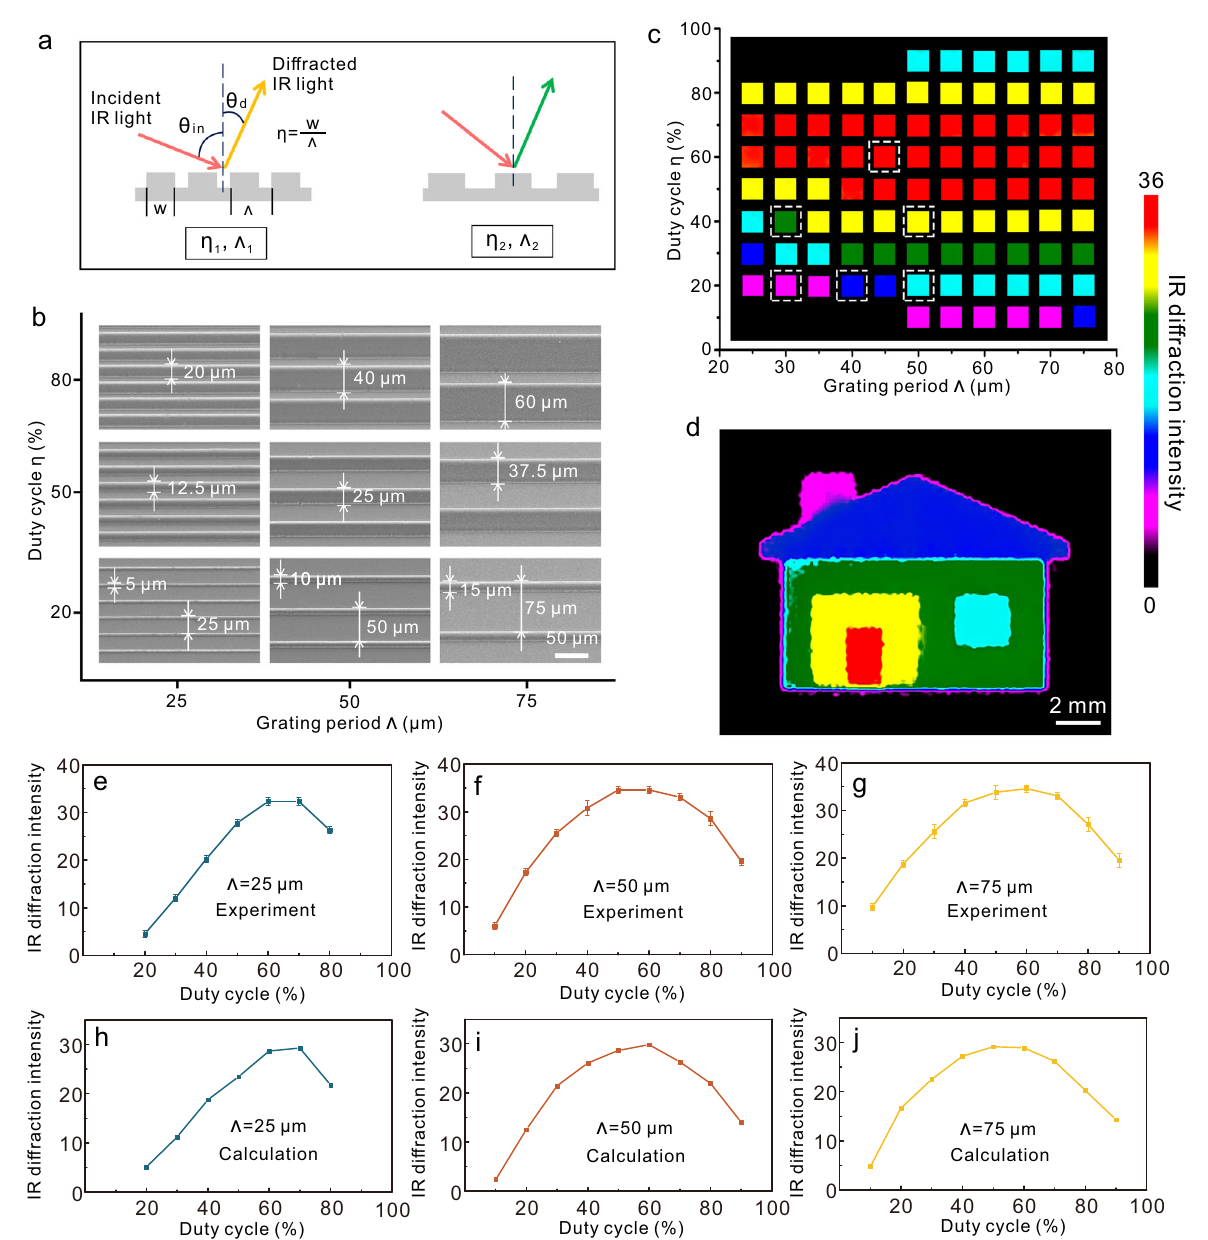
Fig. 2 The response of gratings with different structural parameters to human hand. a Schematic illustration of the interaction between light and gratings with different periods ( Λ ) and duty cycles ( η ). b SEM images of fabricated Al gratings. c The IR color palette generated based on different grating periods and duty cycles. d Color display of a “ house ” based on the selected gratings (dashed boxes) in Fig. 2c. e – g Experimentally measured IR diffraction intensity with different duty cycles. Error bars represent the standard deviation of the mean. h – j FDTD calculated IR diffraction intensity with different duty cycles. incident angle range of Gr and excluded in the incident angle With the fl exibility of adjusting the position of the fi nger, the fi nger can selectively interact with multiple different gratings for range of Gy and Gg, the IR detector will capture the IR structural color from Gr but not from Gy and Gg. If the fi nger moves to R2, the generation of dynamic structural colors. The diffraction which is included in the incident angle range of Gy and excluded equation (Eq. 1) shows that the incident angle ranges are different in the incident angle range of Gr and Gg, the IR detector will for gratings with different periods. With the smaller grating capture the IR structural color from Gy but not from Gr and Gg. period, the incident angle for − 1st diffraction angle θ d = 10° (m = − 1) is larger for one speci fi c wavelength. As shown in Similarly, when the fi nger further moves up to R3, which is Fig. 3d, compared to the grating (Gy) in the middle, the incident included in the incident angle range of Gg and excluded in the angle range (the red triangle) for the grating (Gr) at the left with a incident angle range of Gr and Gy, the IR detector will capture smaller period is closer to the substrate. The incident angle range the IR structural color from Gg but not from Gr and Gy. Besides (the green triangle) for the right grating (Gg) with a larger period the selective interaction between the fi nger and different gratings, on the other hand is further away from the substrate. When the the generated structural colors differ from each other as well due fi nger is placed within range 1 (R1), which is included in the to the difference of duty cycles for different gratings. NATURE COMMUNICATIONS| (2022) 13:1446